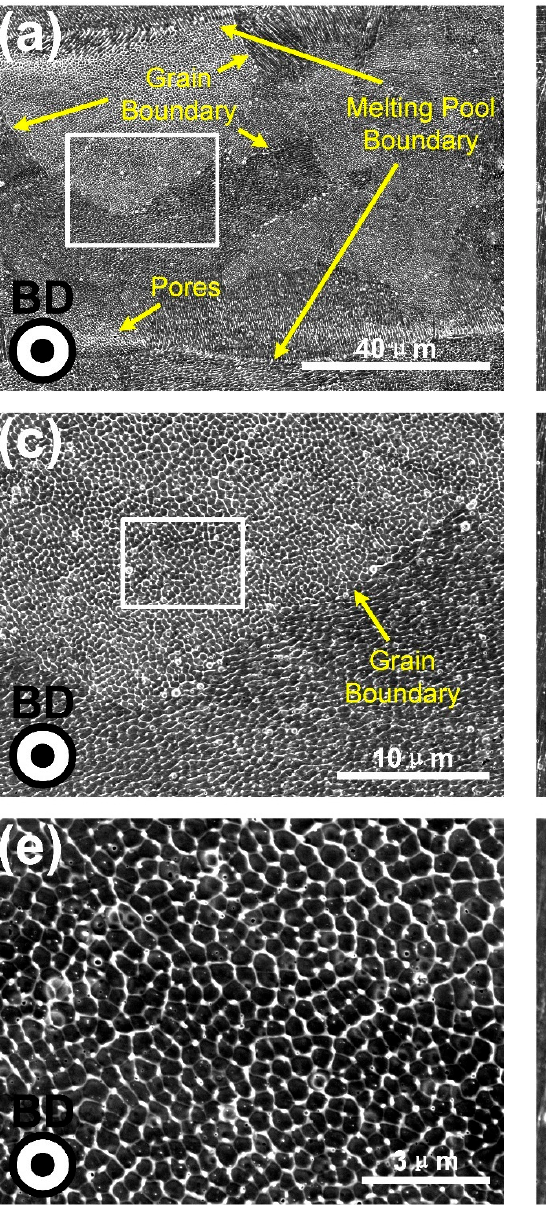
Figure 4. SEM images of top surface XOY plane ( a , c , e ) and cross section ( b , d , f ) in different Figure4. SEMimagesoftopsurfaceXOYplane( a , c , e )andcrosssection( b , d , f )indi ff erentmagnifications magnifications from a single molten channel of the SLM produced CoCrFeMnNi high-entropy alloy. from a single molten channel of the SLM produced CoCrFeMnNi high-entropy